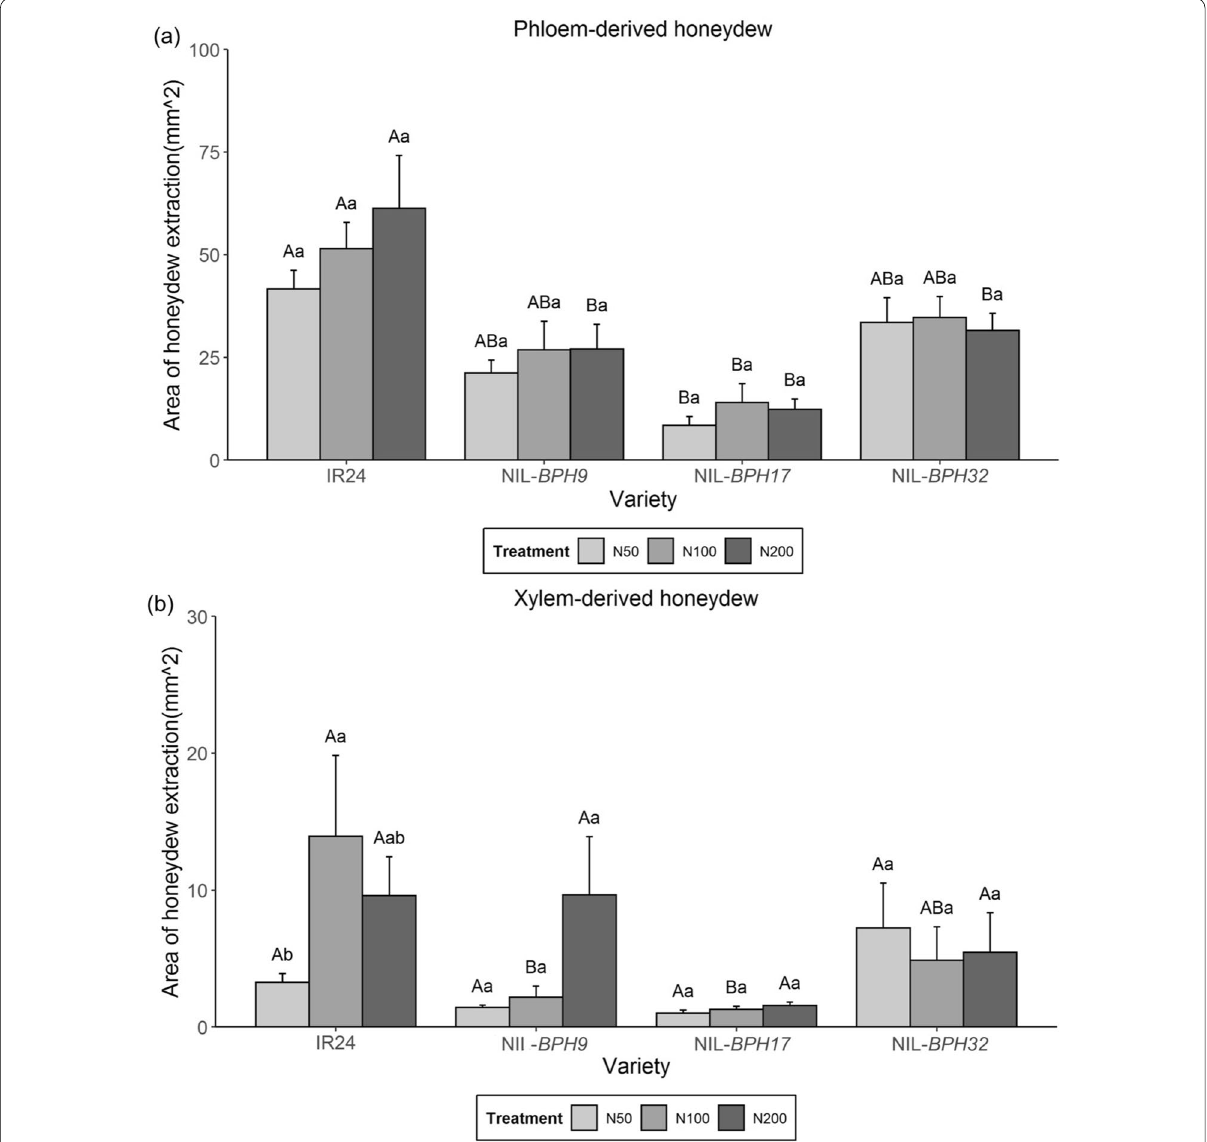
Fig. 2 Areas of honeydew excretion of N. lugens females feeding on IR24, NIL‑ BPH9 , NIL‑ BPH17 , and NIL‑ BPH32 under different nitrogen regimes. a Phloem‑derived excretion. b Xylem‑derived excretion. Means in each column followed by the same capital letter do not differ significantly among varieties ( p < 0.05). Means in each column followed by the same lowercase letter do not differ significantly among different nitrogen treatments. The error bars indicate the